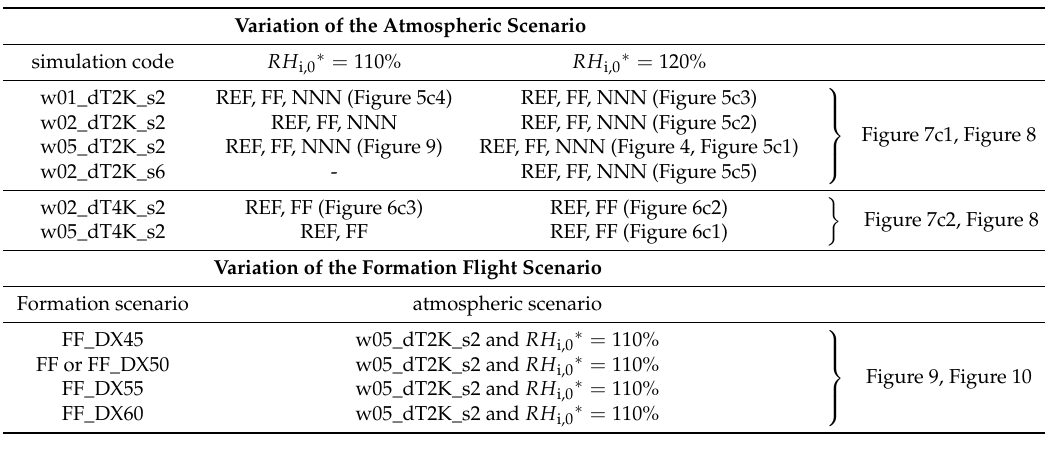
Table 4. Set of simulations: REF denotes reference simulations with a classical single aircraft contrail, FF the default formation flight simulation and NNN simulations of a classical single aircraft contrail with upscaled IC numbers matching those of corresponding FF simulations. In an FF sensitivity test, further formation flight scenarios are used as input and those simulations are referred to as FF_DX??, as the lateral offset DX of the two aircraft in formation was varied in preceding vortex phase simulations. Various atmospheric scenarios are listed: w01, w02 and w05 refers to an updraught speed w syn = 1,2 and 5cm s − 1 , s2 and s6 refers to wind shear s = ∂ u / ∂ z = 0.002 or 0.006s − 1 . The initial relative humidity RH i,0 ∗ is either 110% or 120%. Simulations without natural cirrus formation and final adiabatic cooling ∆ T = 2K use the code dt2K and simulations with natural cirrus formation around the CC use the code dT4K. The codes in parentheses or after the single braces starting with “F” refer to the number of the figure (and column) in which the simulation is